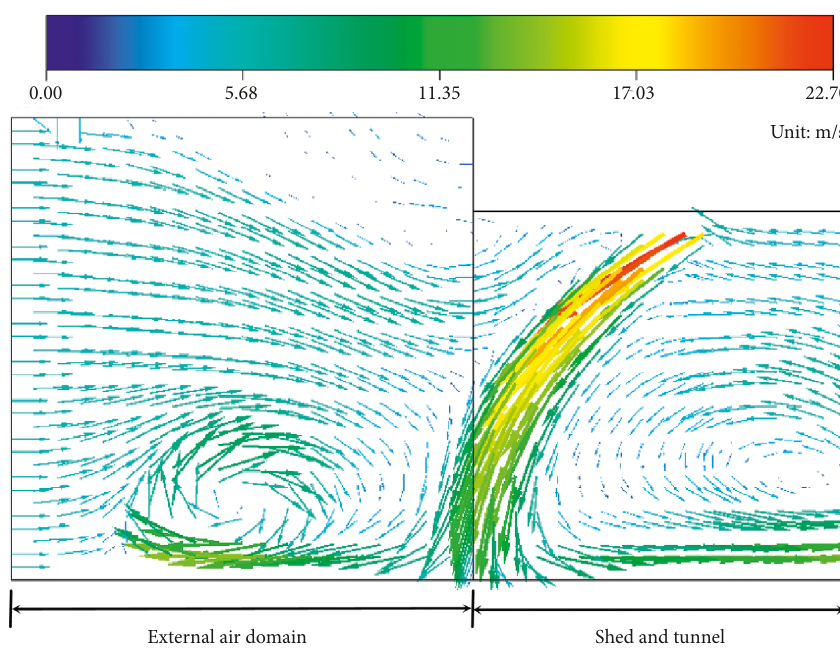
Figure 9: Velocity vector diagram of tunnel portal